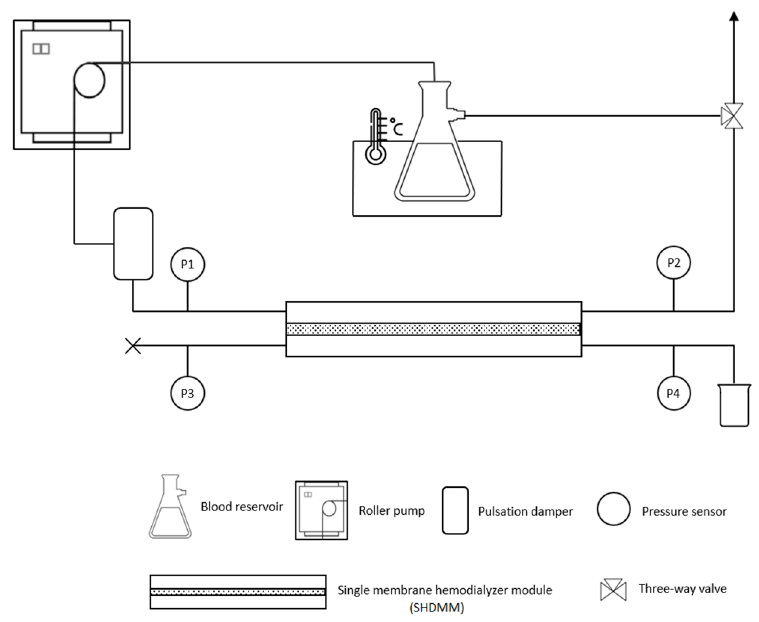
Figure 2. Schematic representation of the experimental setup used for permeation experiments under dynamic conditions.